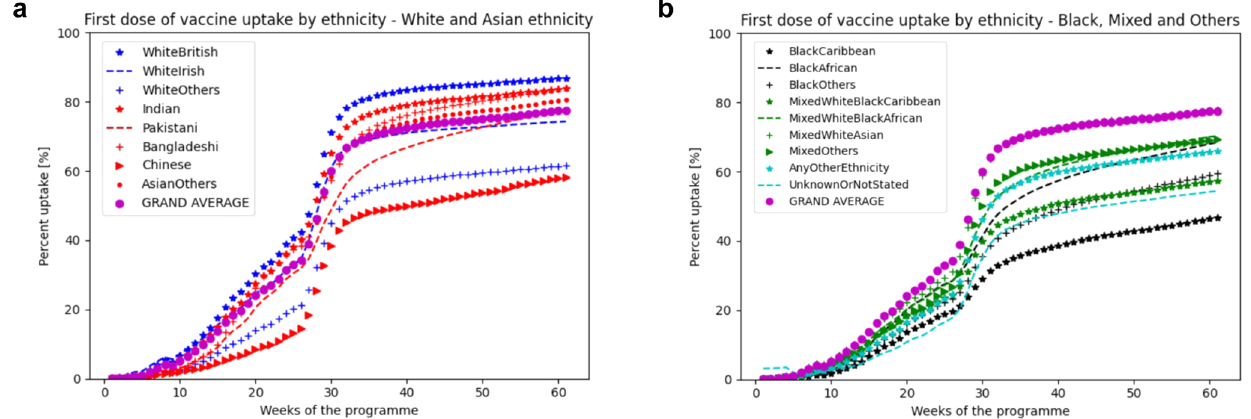
Fig. 2 | COVID-19 vaccine uptate by ethnicity, normalised for date of vaccine avalablity by age. COVID-19 fi rst-dose vaccine uptake by ethnicity, normalised for date of vaccine availability by age group and presented for the fi rst-dose by aggre- gated ethnic group ( a ) and by speci fi c ethnic group ( b ). The “ GRAND AVERAGE ” represents the population average overall, presented as a reference for each graph. a Presents fi rst-dosevaccineuptakebyaggregatedethnicgroup,asinSupplementary Table 2; b presents fi rst-dose vaccine uptake by speci fi c ethnic group, as in Supple- mentary Table 2 with the exception of not stated/unknown which remains